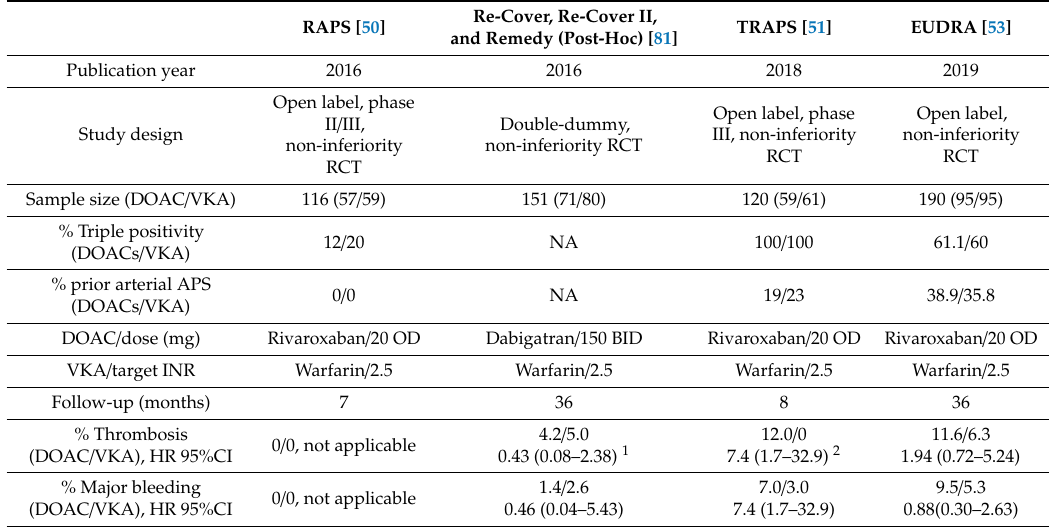
Table 2. Clinical trials of direct oral anticoagulants for thrombotic antiphospholipid syndrome. Re-Cover, Re-Cover II, TRAPS [51] EUDRA RAPS [50] and Remedy (Post-Hoc) [81]